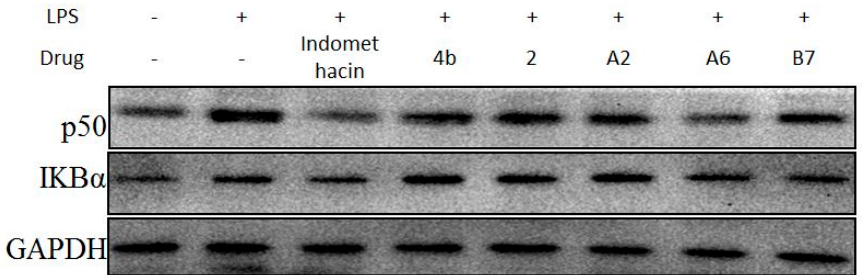
Figure 10. Immunoblotting of p50 and IKB α of NF- κ B signaling pathway in RAW264.7 cells treated with 10 μ M compound 4b , 2 , A2 , A6 , B7 , or indomethacin. GAPDH was used as a loading control.